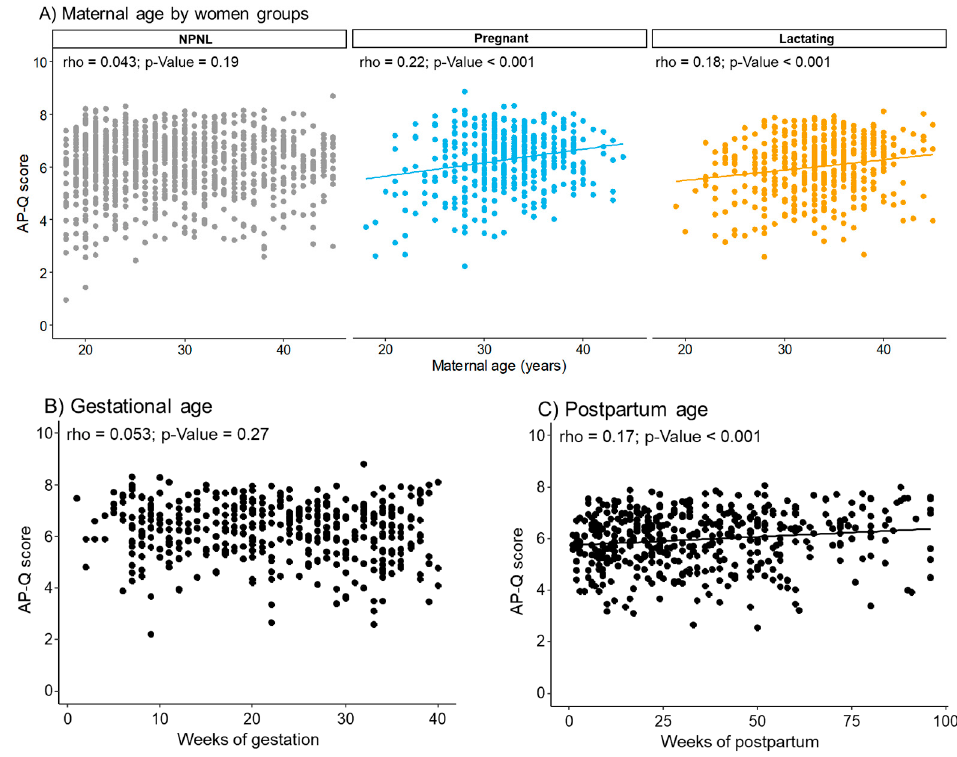
Figure 3. Correlation between Adherence to the Healthy Food Pyramid questionnaire (AP-Q) score and maternal age by women groups ( A ), and gestational age in pregnant women ( B ), and postpartum age in lactating women ( C ). p -Value was extracted by Rho-Spearman correlations. Linear trend is shown in significant correlations. NPNL = non-pregnant/non-lactating.